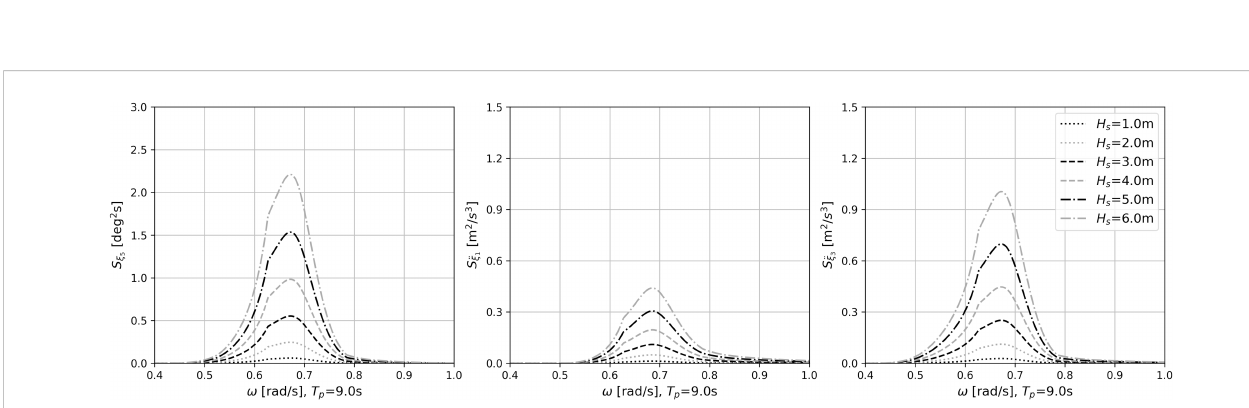
FIGURE 13 Sample response spectrum of pitch ( x 5 ), and the horizontal (¨ x 1 ) and vertical (¨ x 3 ) accelerations of B16 for varied H s with a constant T p =9.0